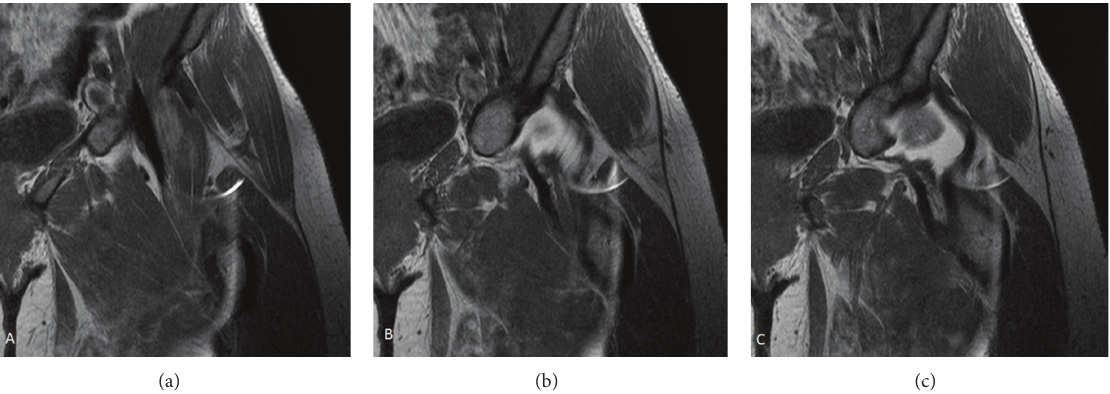
Figure 2: A series of T2-weighted, coronal MR arthrograms of the left hip taken 3 months prior to the patient’s repeat left psoas release. The images identify an iliopsoas pseudo-tendon anterior to the hip joint (a). This pseudo-tendon extends beyond the hip joint (b) and is inserted into the superior aspect of the lesser trochanter